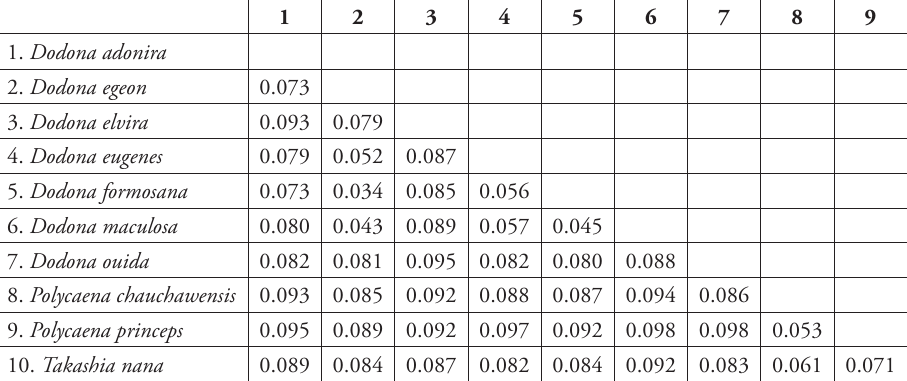
Table 2. K2P-distances among species of this